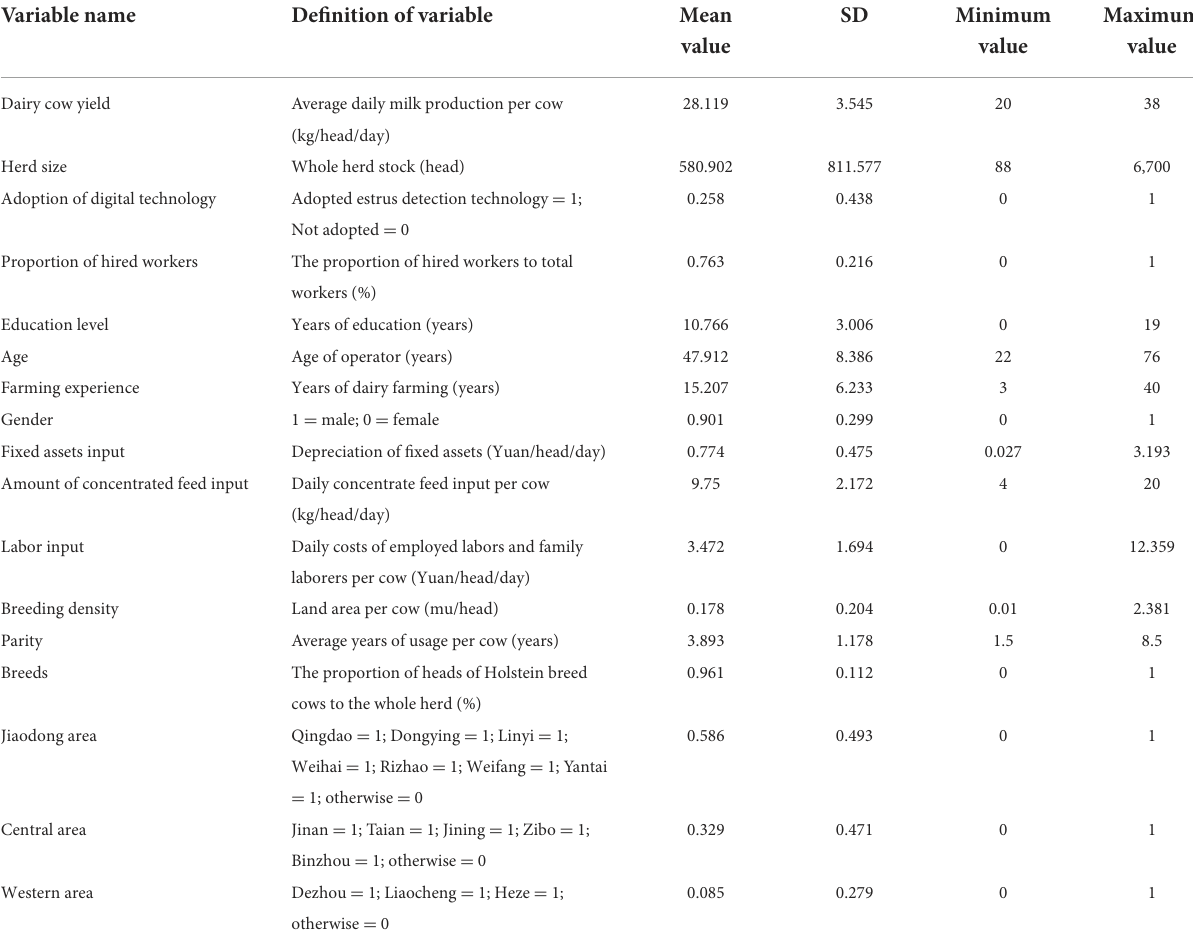
TABLE 1 Descriptive statistics results of model